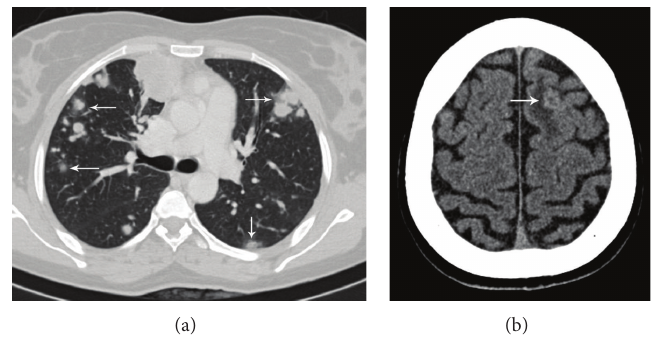
Figure 13: Choriocarcinoma with widespread metastases, presenting with seizures. CT chest (a) shows multiple metastatic lung nodules. Ground glass halo (arrows) around many of these nodules represents hemorrhage. Noncontrast CT brain (b) demonstrates a round, mildly hyperdense lesion (arrow) at gray-white matter junction in the left frontal lobe with surrounding vasogenic edema suggestive of hemorrhagic brain metastasis.